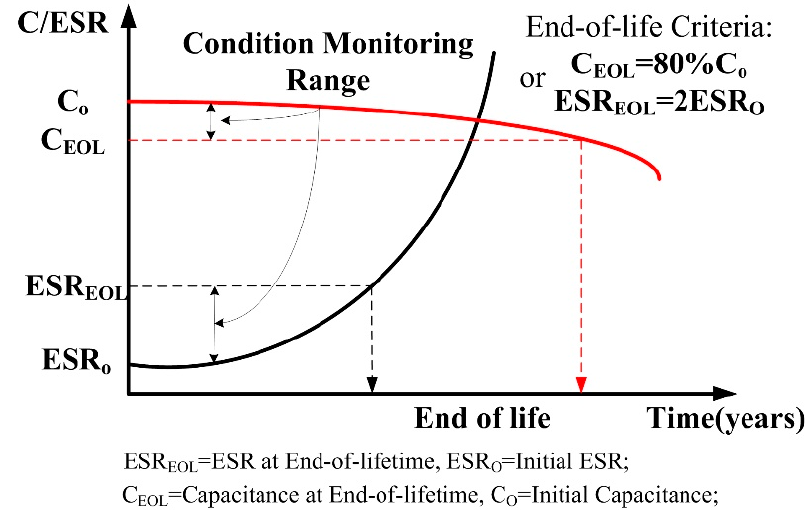
Figure 4. Illustration of C and ESR as an indicators of capacitor degradation.